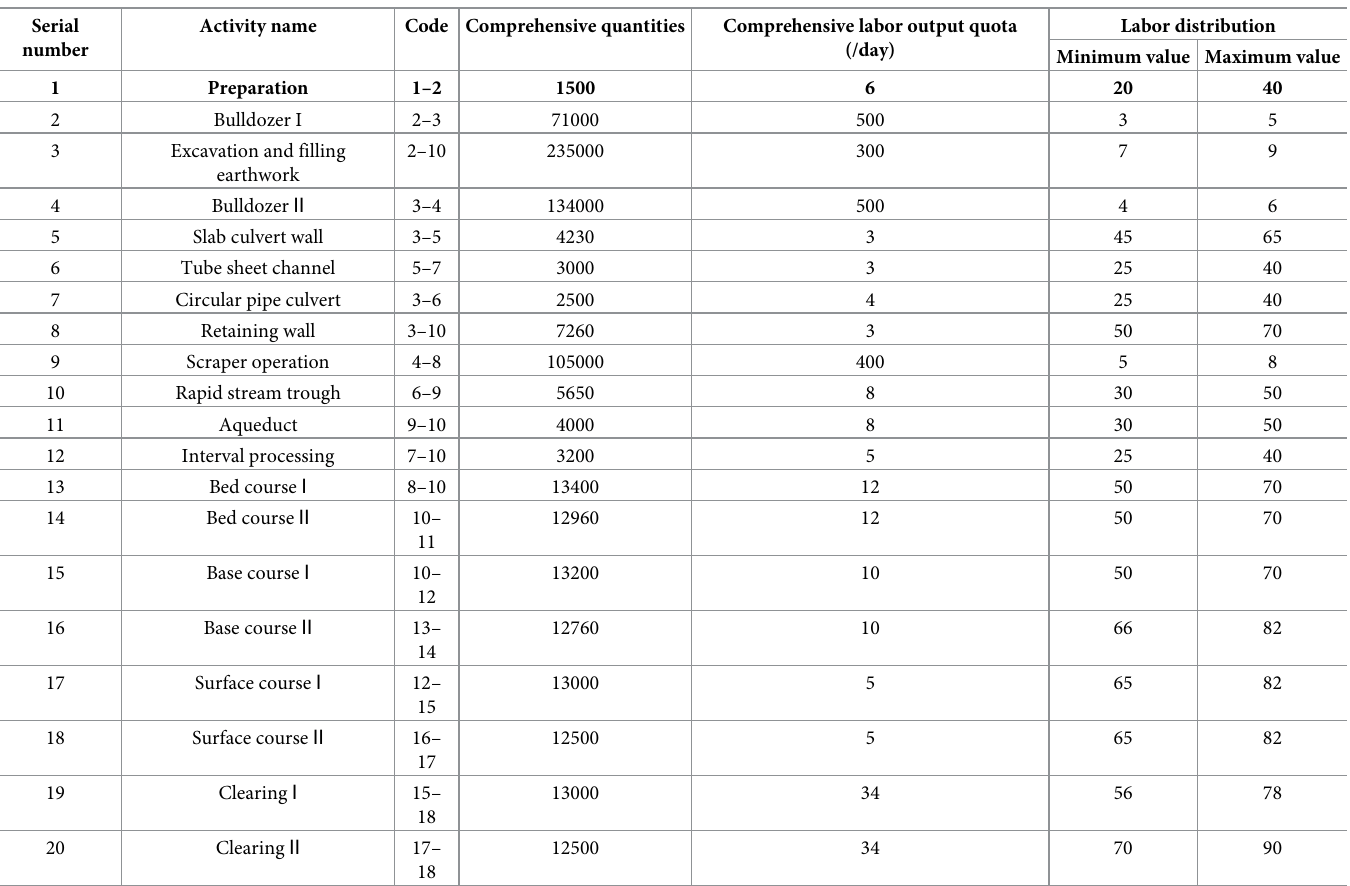
Table 2. Relevant parameters of each activity.